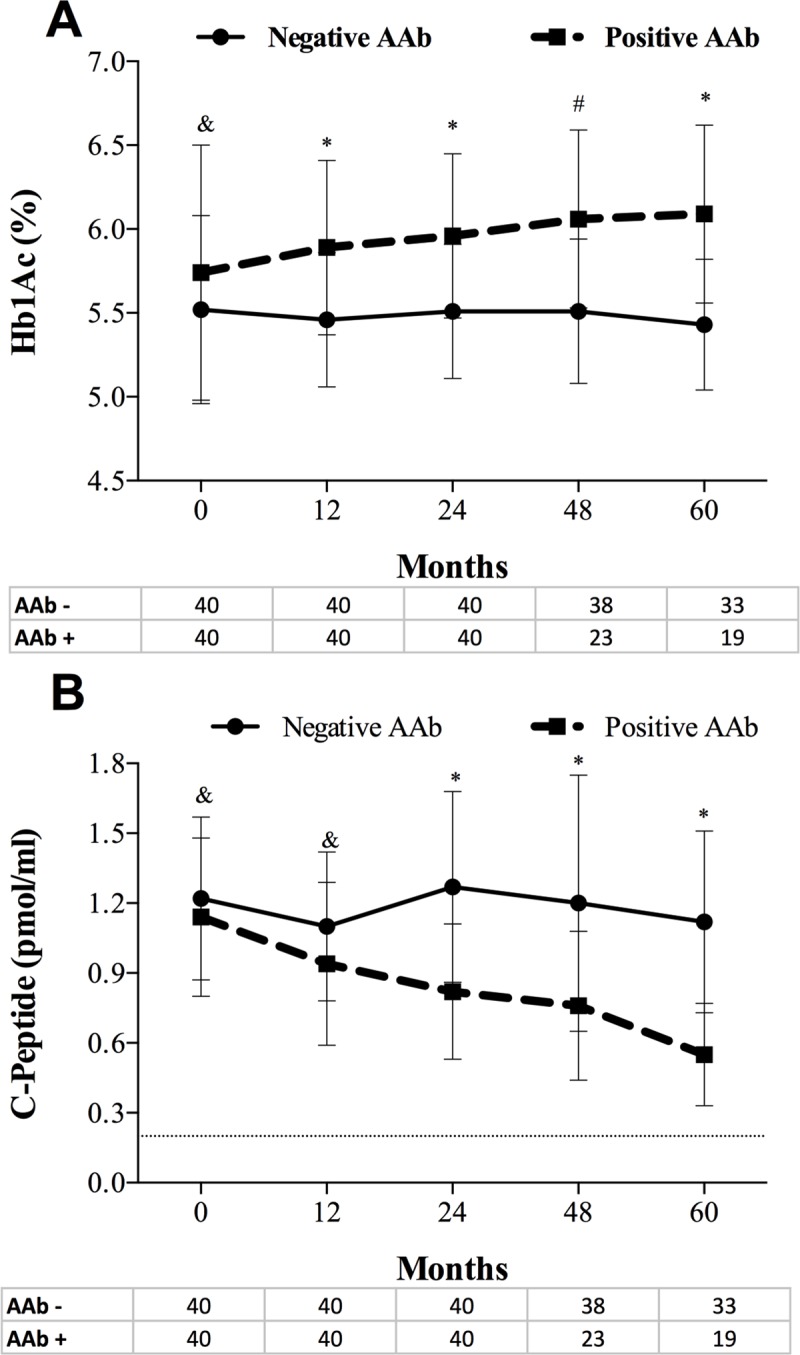
Glycated hemoglobin (A) and C-pep (B) serum levels among patients with positive and negative pancreatic AAb. The dark-dashed line represents positive AAb patients, and the continuous line represents AAb negative patients. I bar represents standard deviation. The number of patients at each time-point is depicted under x-axis. & p>0.05, * p<0.001, # p<0.01.